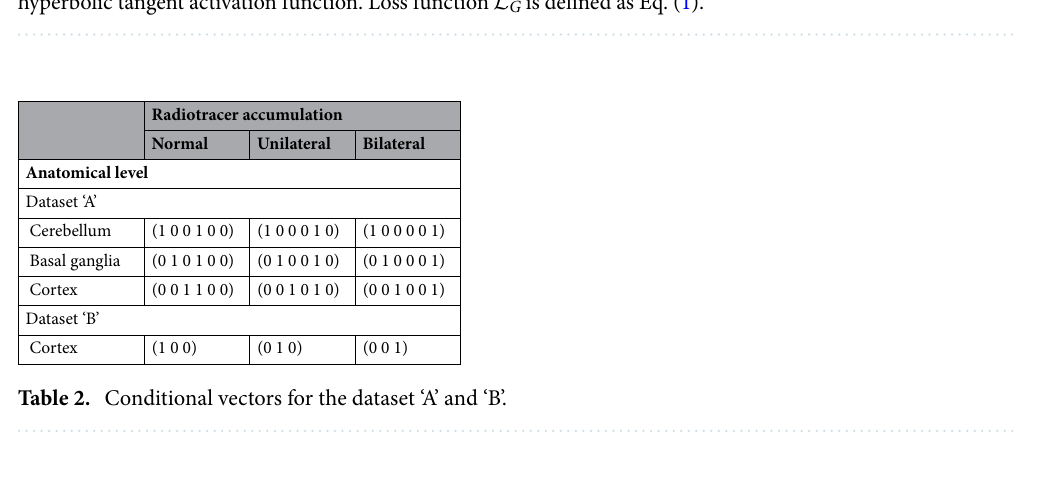
Figure 1. Generator network in our model. The latent vector and the conditional vector for specifying patterns of radiotracer accumulation served as input to the generator to synthesize a two-dimensional brain SPECT. Symbols F, n, s and p denote channels of output feature maps, number of neurons, strides and padding, respectively. The “same” for padding indicates that padding is applied to the input feature map so that the height and width of the input and output feature maps are not changed. GLU is a gating unit proposed in 42 . Tanh is a hyperbolic tangent activation function. Loss function L G is defined as Eq. (1).